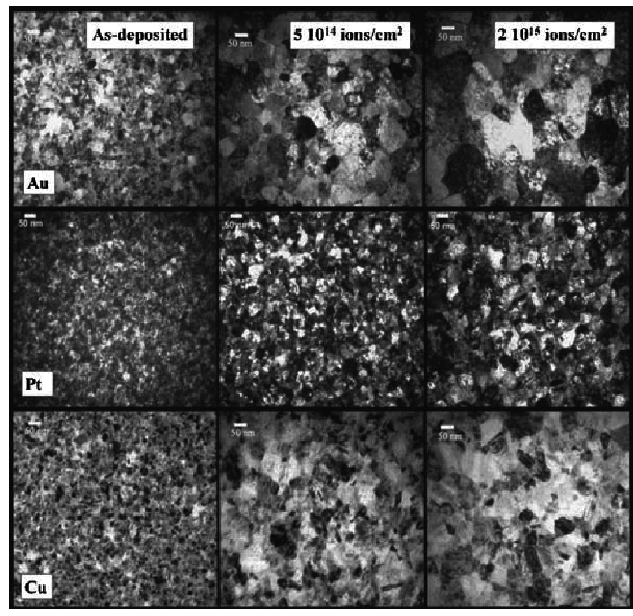
Figure 5. Sequence of bright-field TEM images taken at different ion doses showing grain-growth induced by ion irradiation at room temperature; from top to bottom: pure Au thin-film irradiated with 500 keV Ar ions, Ptthin-film irradiated with 500 keV Ar ions, and Cu thin-film irradiated with 500 keV Kr ions [81]. The scale mark is 50 nm.